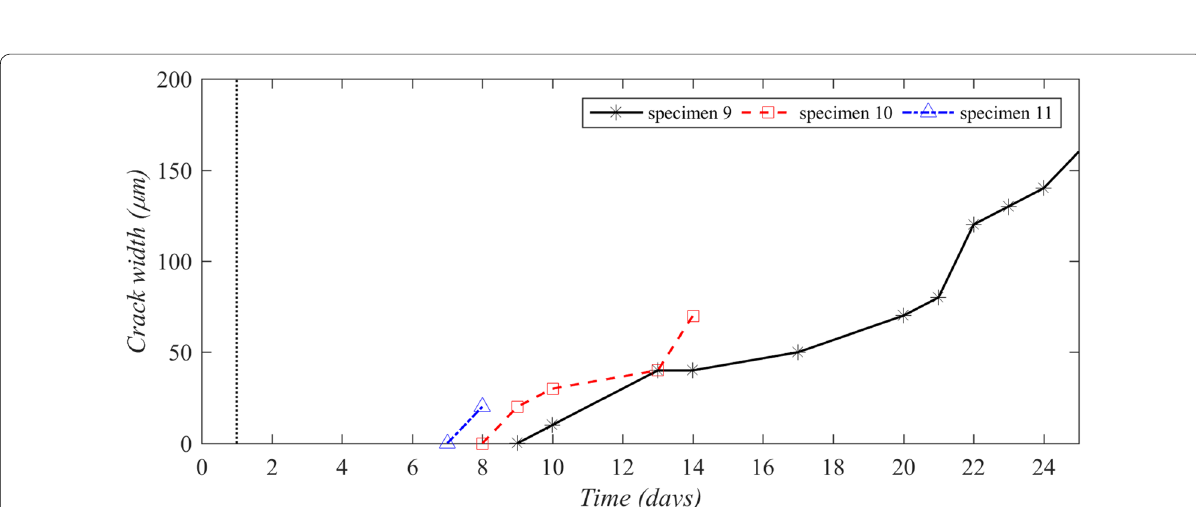
Fig. 10 Crack width evolution measured for the three